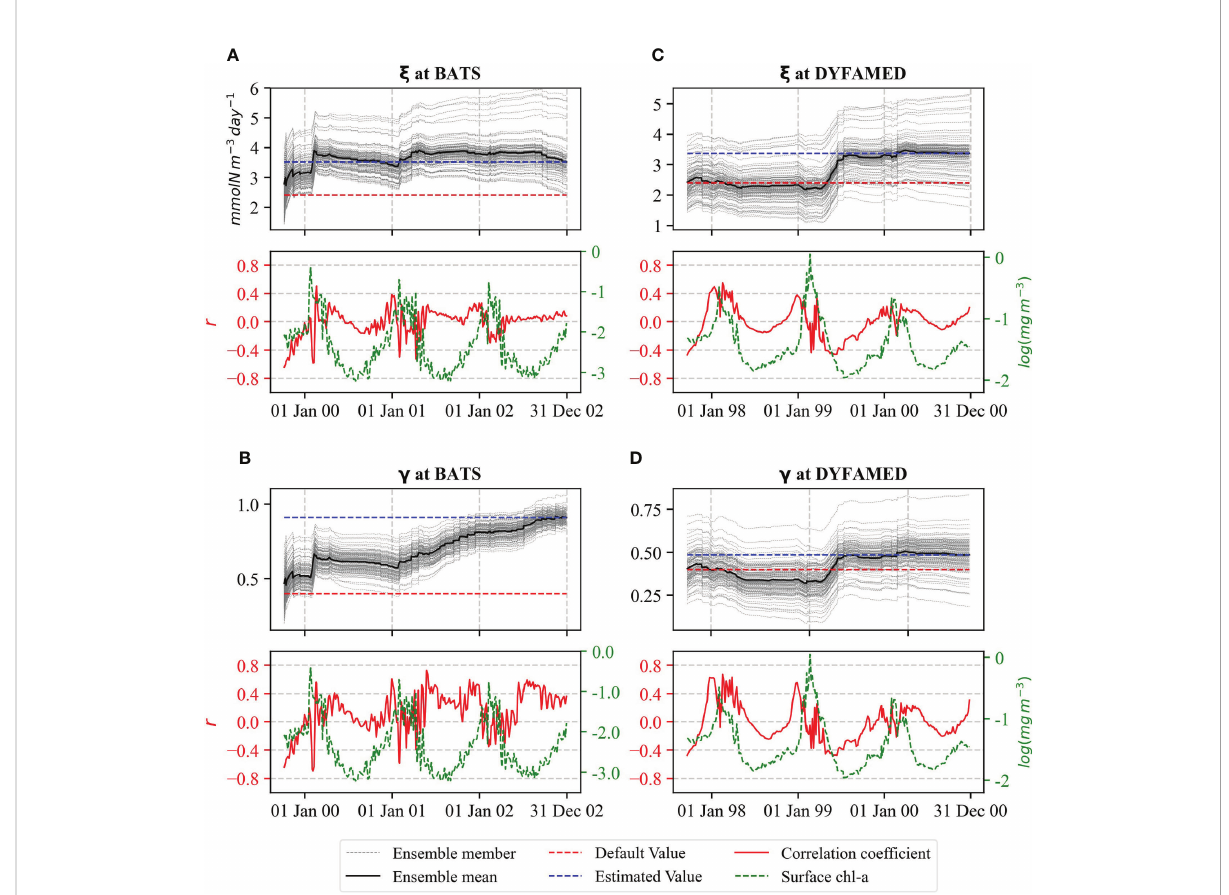
FIGURE 6 Evaluation of x for (A) BATS and (C) DYFAMED, and g for (B) BATS and (D) DYFAMED analogous to Figure